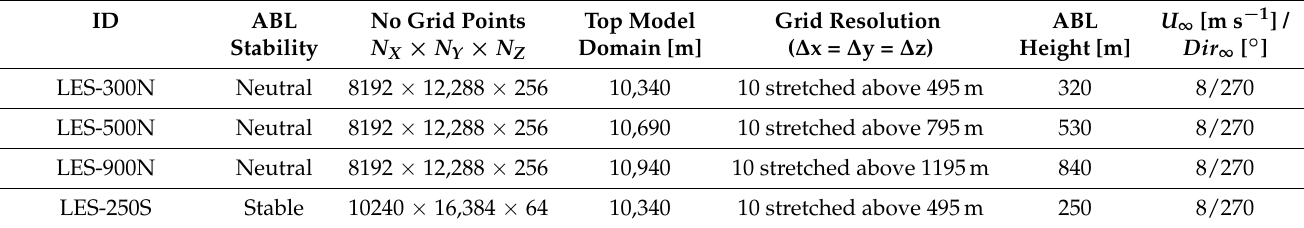
Table 3. LES model configuration cases for the cluster